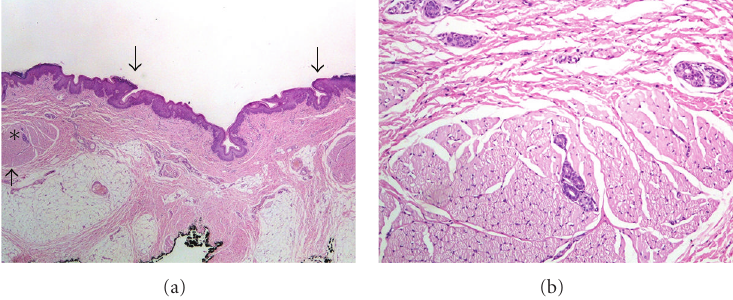
Figure 4: (a) On low power view ( × 2) the indentation of the skin was also covered by stratified squamous epithelium with surface parakeratosis. The upper arrows point to the transition to normal orthokeratotic epidermis. The underlying dermis showed absence of adnexal structures. The edges of the indentation were marked by the presence of bundles of striated muscle fibers (lower arrow). The “ ∗ ” sign marks the area shown in higher magnification in (b) (hematoxylin-eosin stain). (b) Striated muscle bundles at the edges of the skin indentation surround and entrap sweat gland ducts ( × 10, hematoxylin-eosin stain).